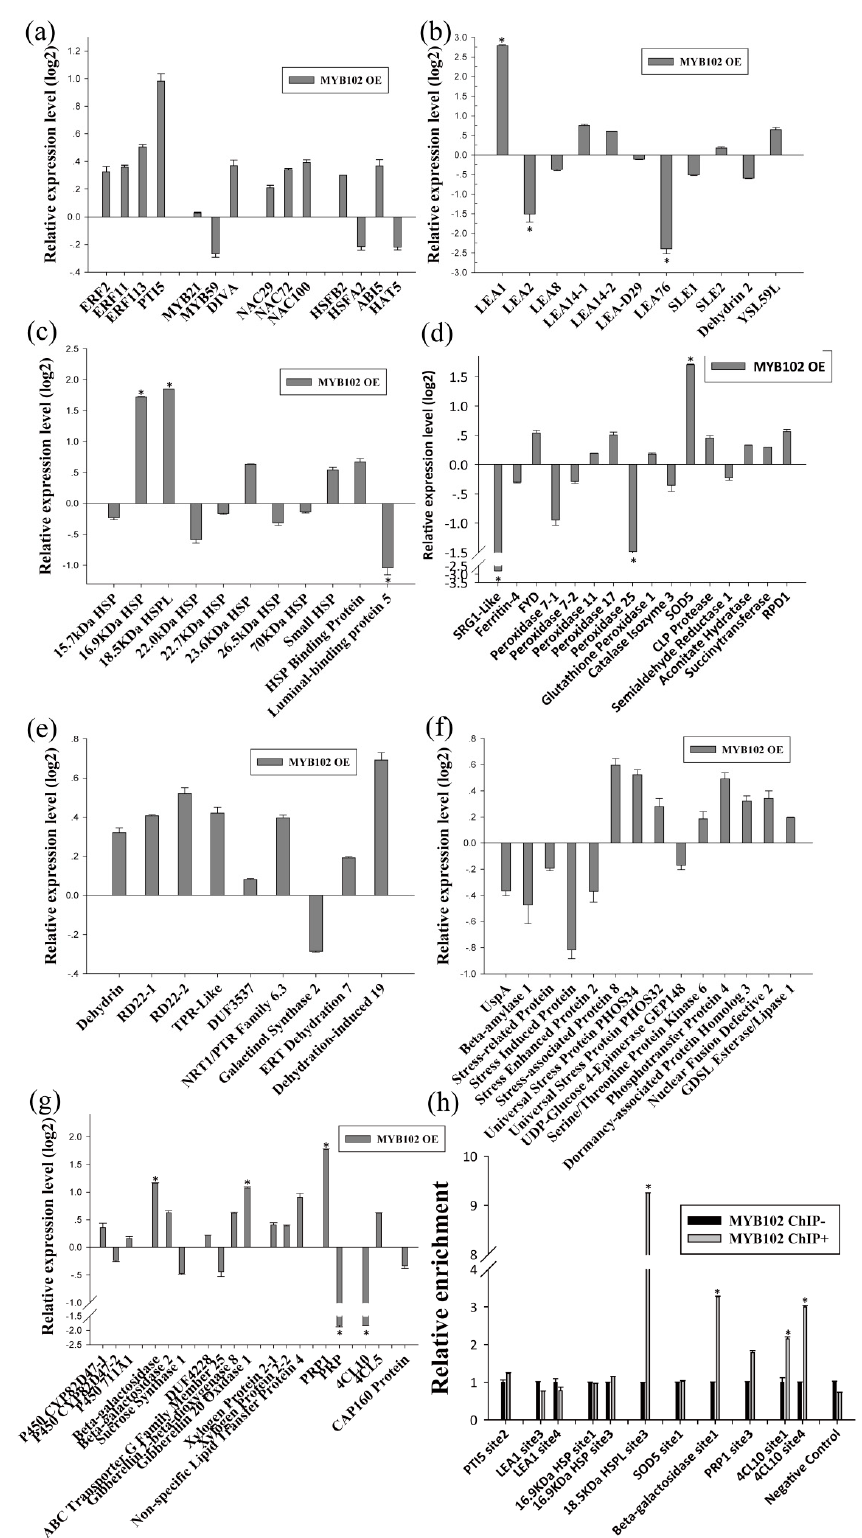
Figure 5. Determination of the genes regulated by BpMYB102. ( a – g ) Investigation of the genes regulated by BpMYB102 using qRT-PCR. Transcription factors ( a ), late embryogenesis abundant proteins ( b ), heat shock proteins ( c ), ROS-scavenging-related proteins ( d ), water deprivation-related proteins ( e ), stress-related proteins ( f ), and others ( g ). The transcripts of the genes in control plants